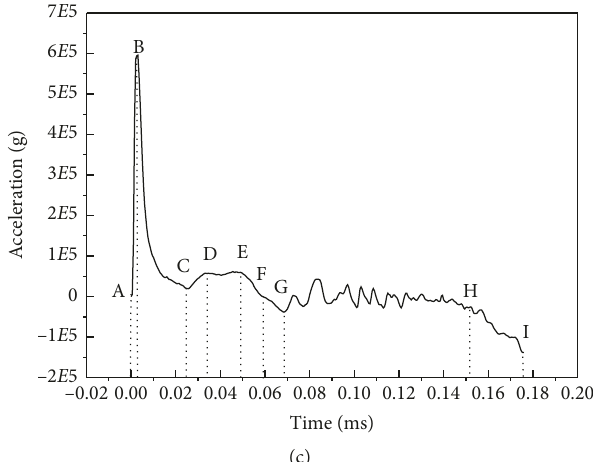
Figure 6: Simulation results of the pyrotechnic cutter, for the connection diameter of 5 mm and the spacing of 6.5mm. (a) Pressure history of the cutter blade’s end face. (b) Velocity history of the cutter blade. (c) Acceleration history of the cutter blade.